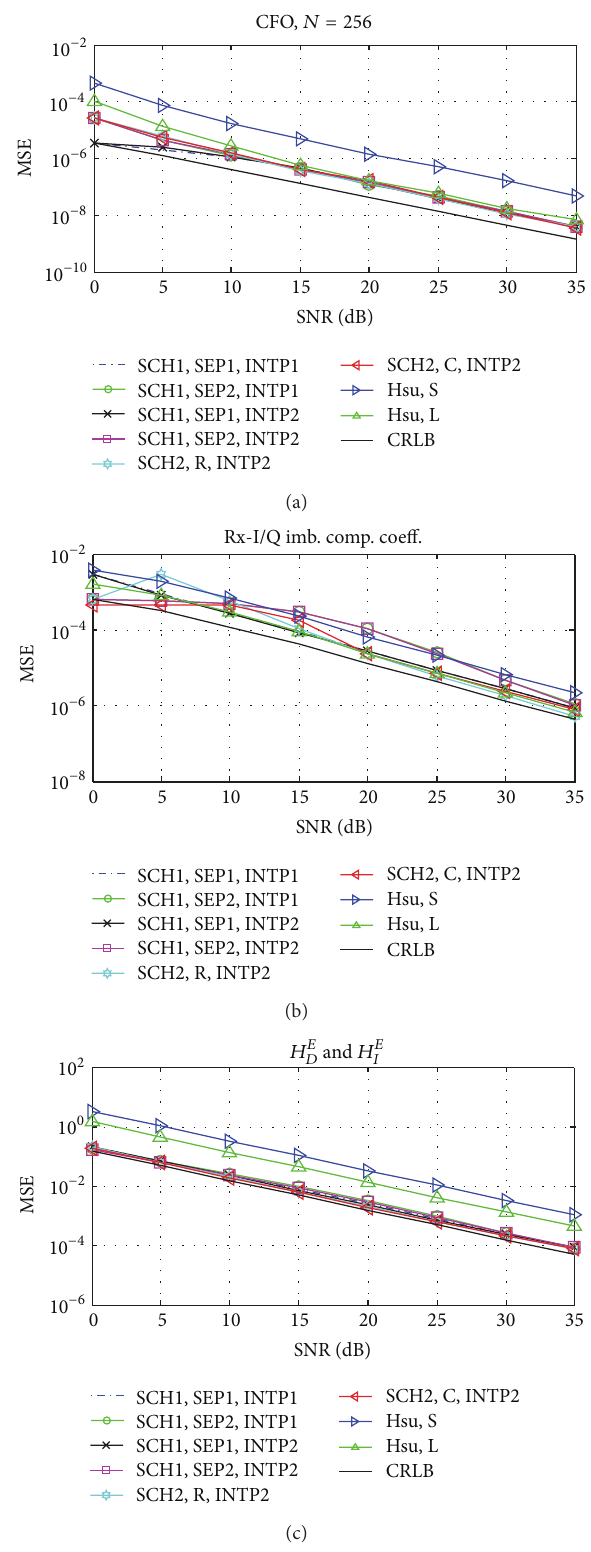
Figure 7: Estimation MSE as a function of SNR, 𝑁 𝐼 = 1, 𝑁 = 256, and 𝜖 = 0.25